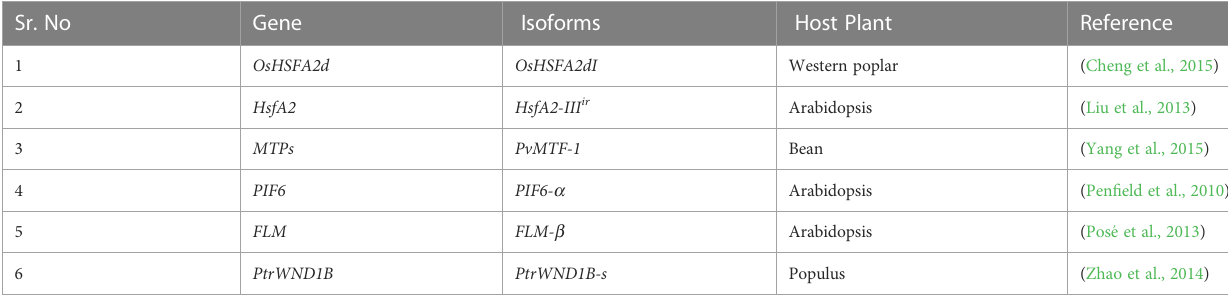
TABLE 2 List of introns retaining transcripts involved in transcriptional activation. Sr.